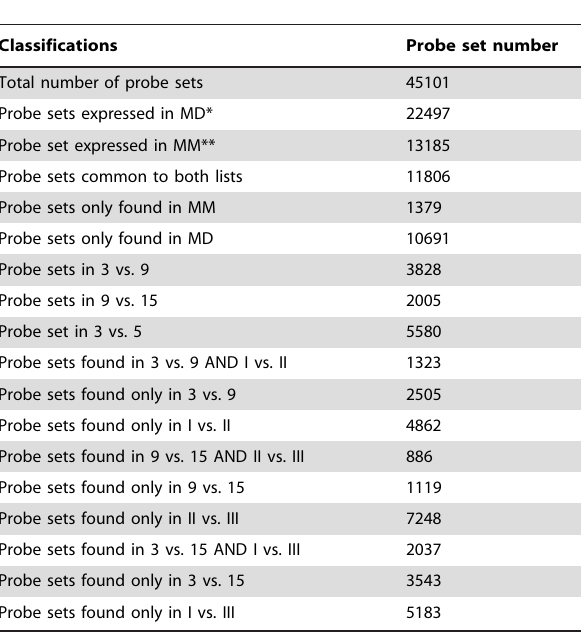
Table 2. Comparisons between microdissected and micromass